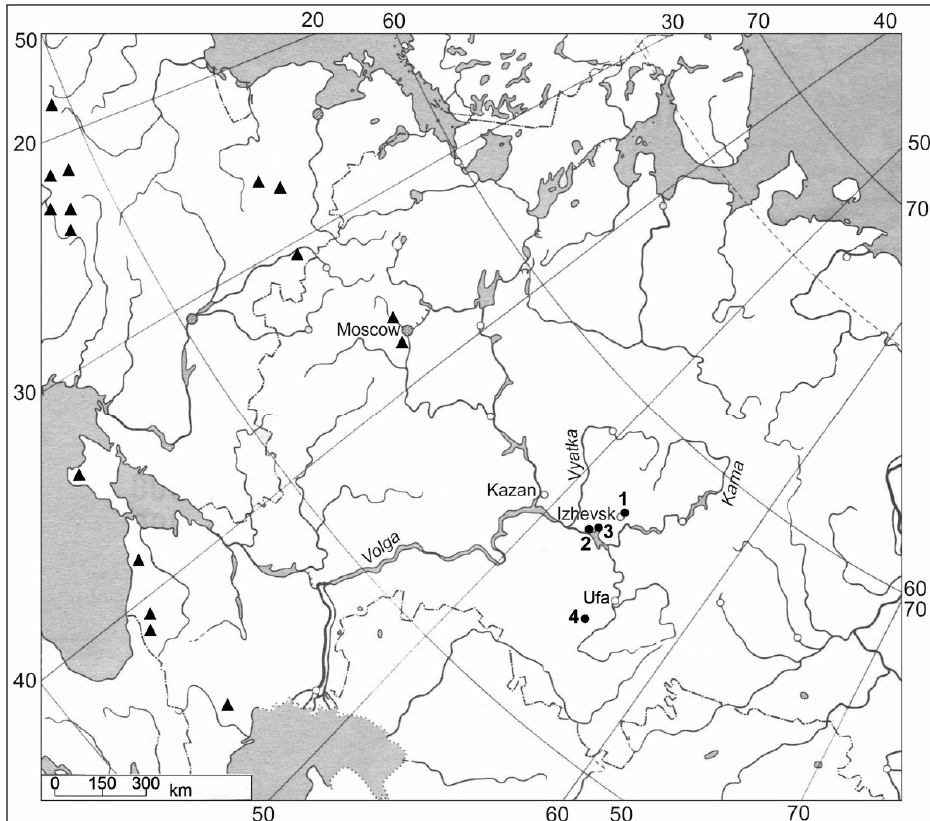
Figure 7. Typha lepechinii sp. nov. (points 1–4): distribution area. 1—Russia, Udmurt Republic;